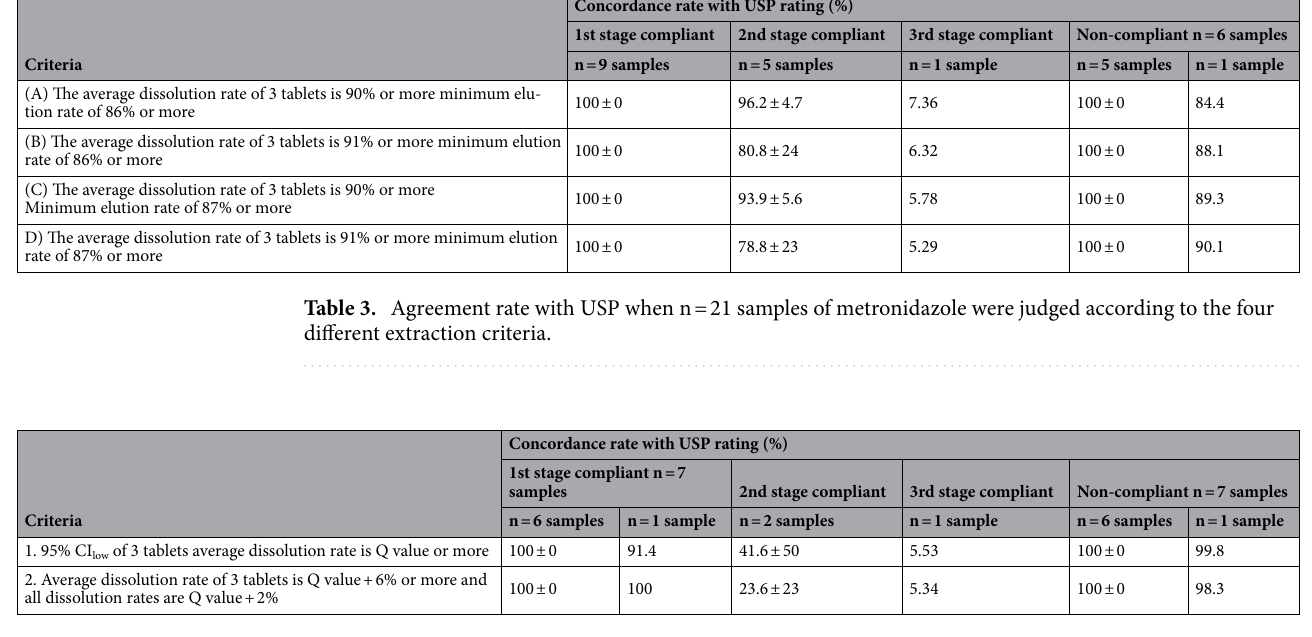
Table 4. Agreement rate with USP for cimetidine using the two types of selected criteria in the small-scale dissolution test.